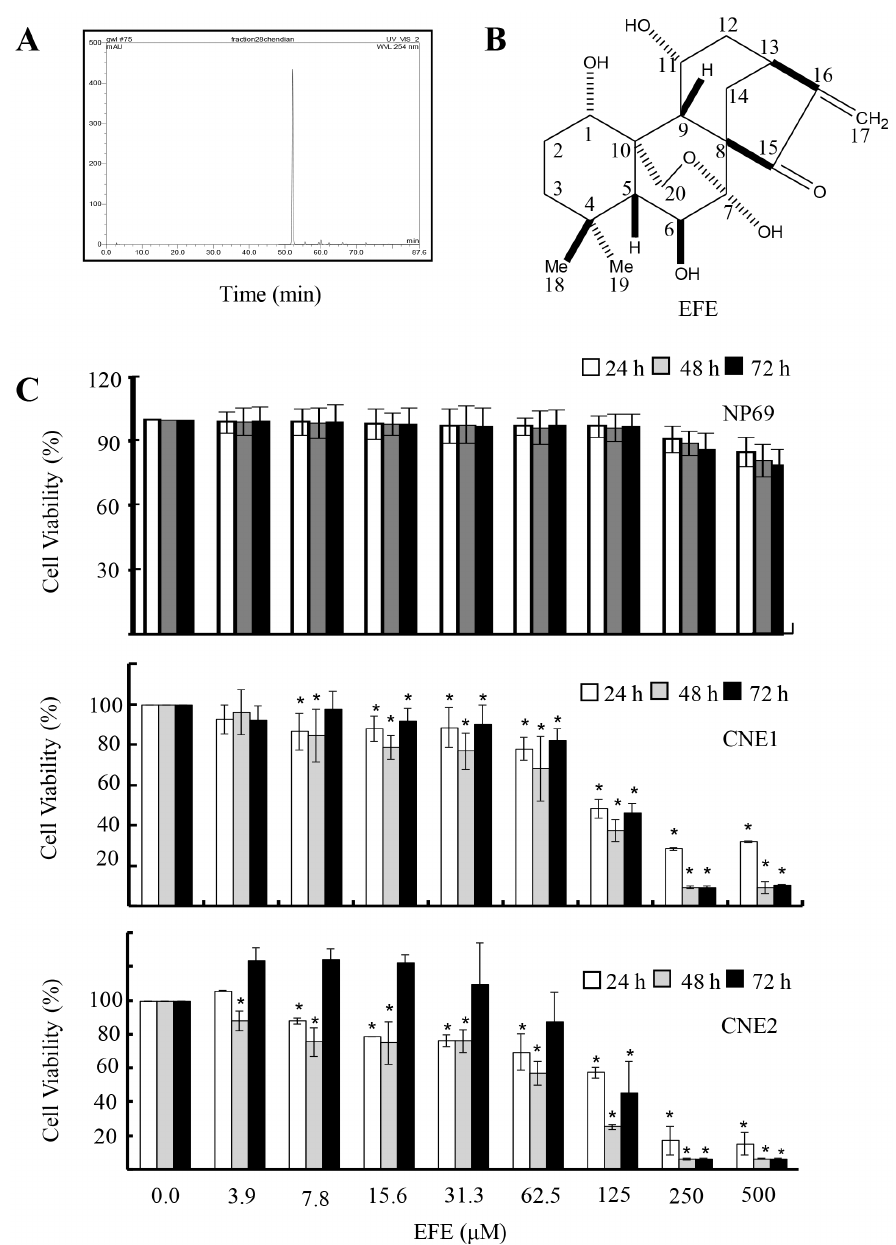
Figure 1. Purification and identification of effusanin E from R.serra . ( A ) HPLC analysis of effusanin E. ( B ) The structure of effusanin E (EFE). ( C ) Human CNE1 and CNE2 were treated with effusanin E (EFE) at 3.9–500 m M for 24 hours, 48 hours and 72 hours. The viability of the cells was determined using the MTS assay. Cells treated with the vehicle control (DMSO) were used as the reference group, with its cell viability set at 100%. The percent cell viability of each treatment group was calculated relative to that of cells treated with the vehicle control. The data are presented as the mean 6 SD of three separate experiments. * represent P , 0.05.